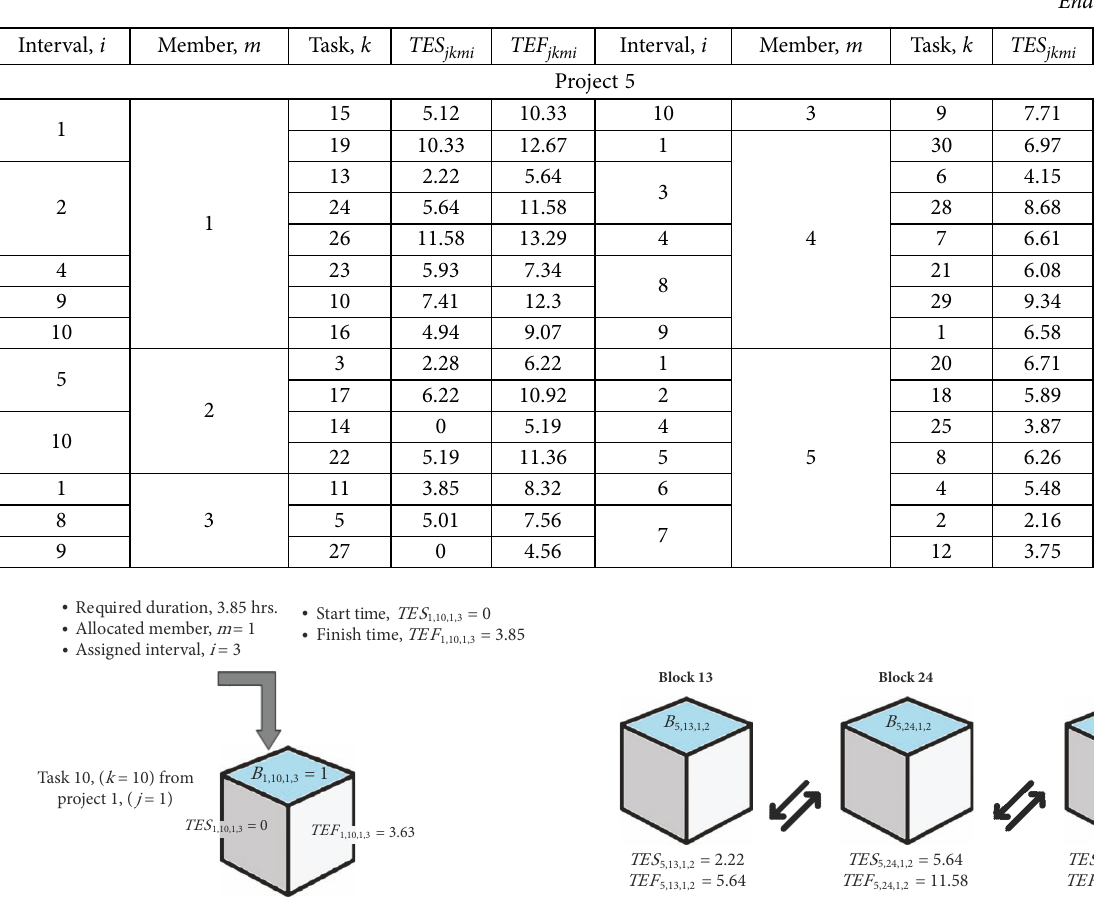
Figure 9. Example of optimal sequencing information to blocks Figure 10. Example of blocks sequence in project 5